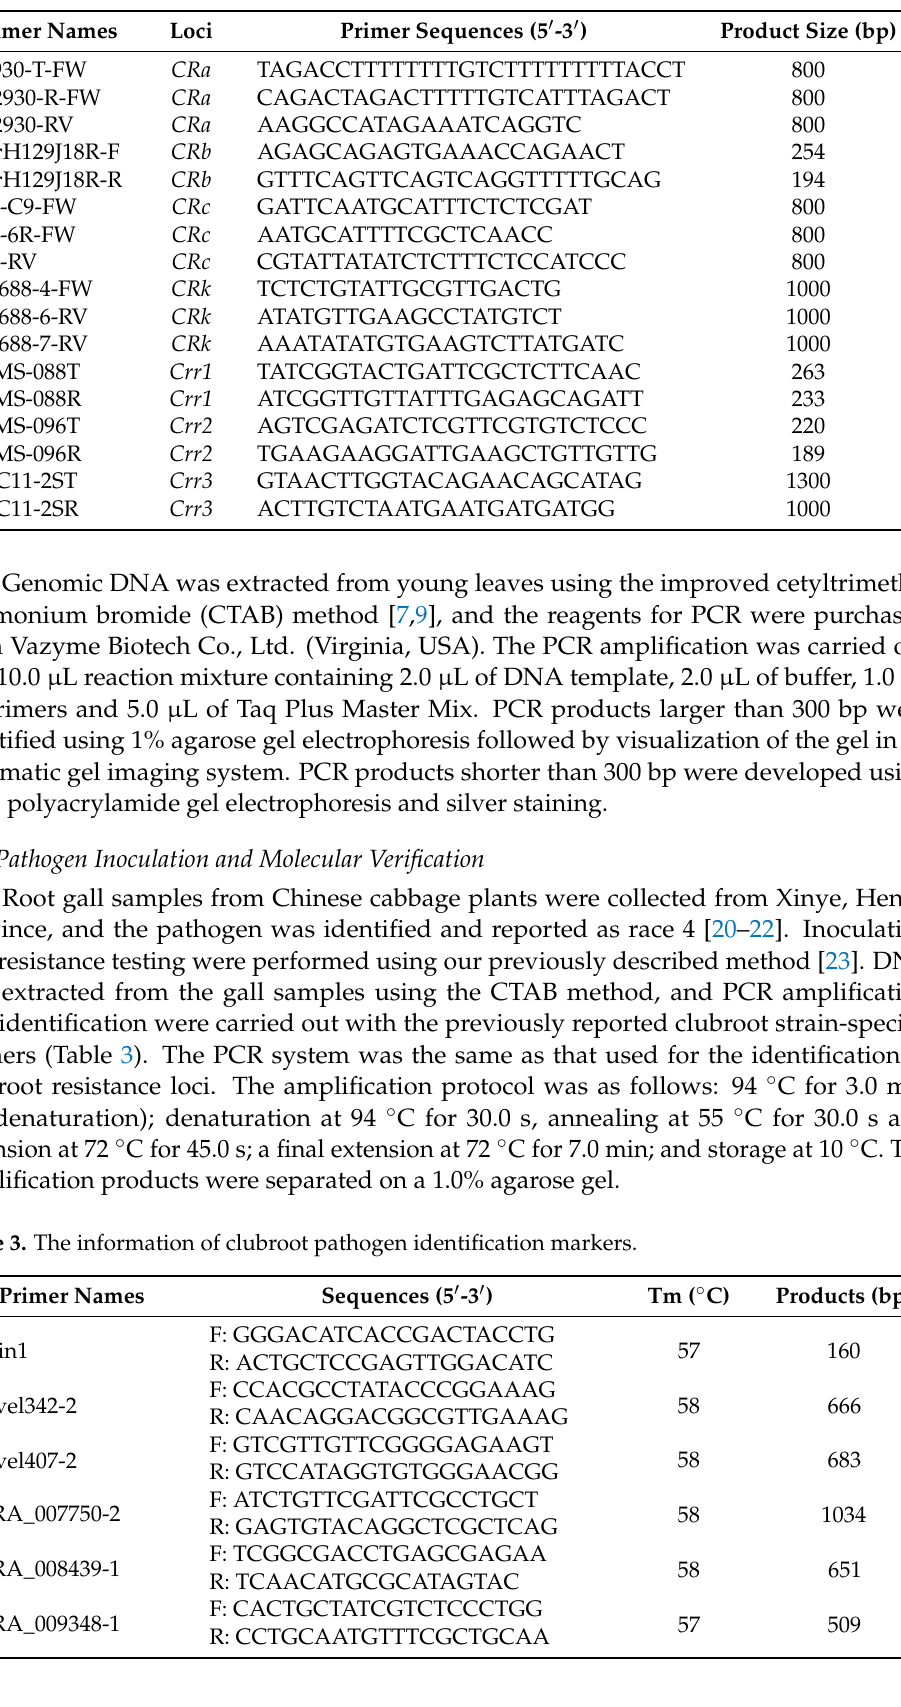
Table 2. Information of selected specific CR markers.